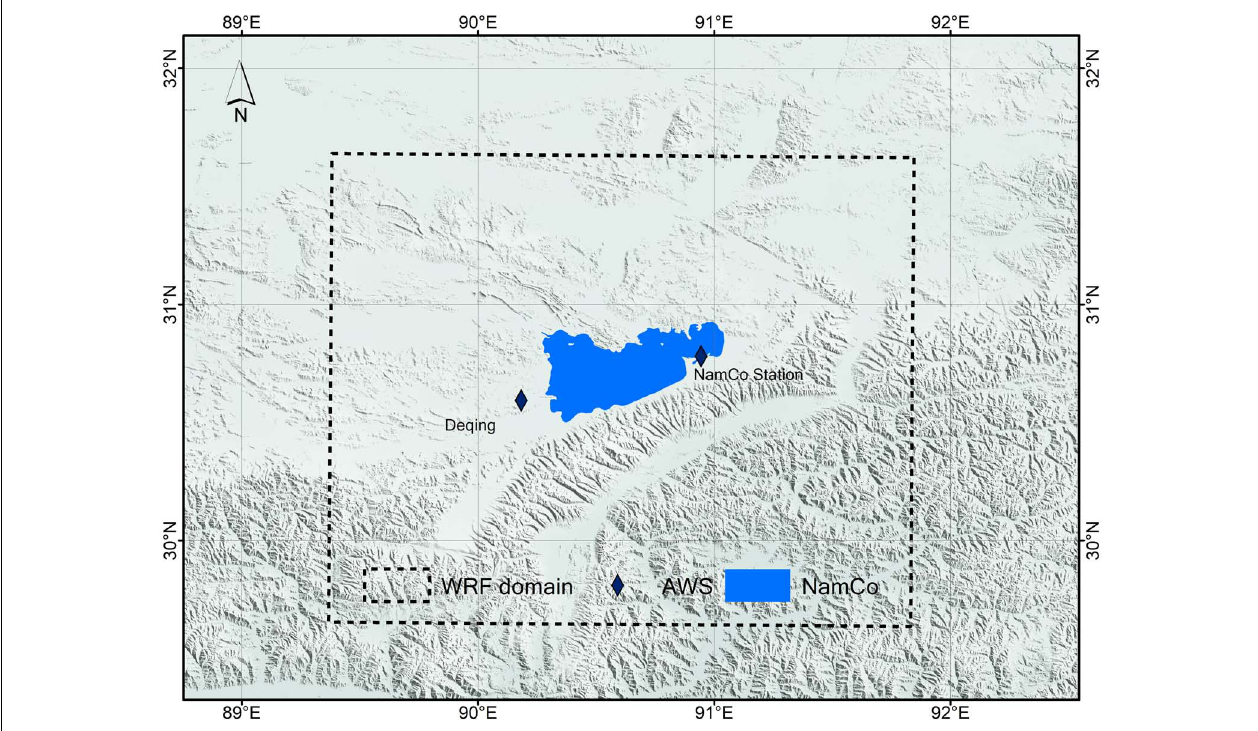
FIGURE 1 | Location and topography of Nam Co Lake and the two nearby meteorological stations (Nam Co and Deqing stations). The black dash box denotes the position of the simulation domain. The AWS is the abbreviation of Automatic Weather Station.